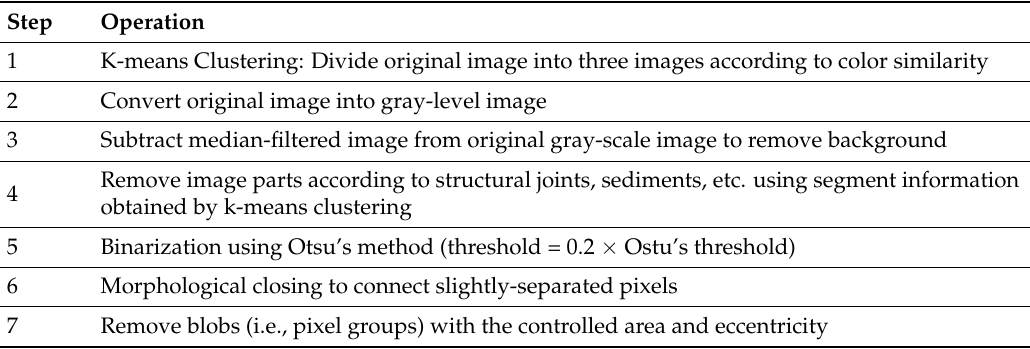
Table 1. Seven image processing steps for the crack detection.